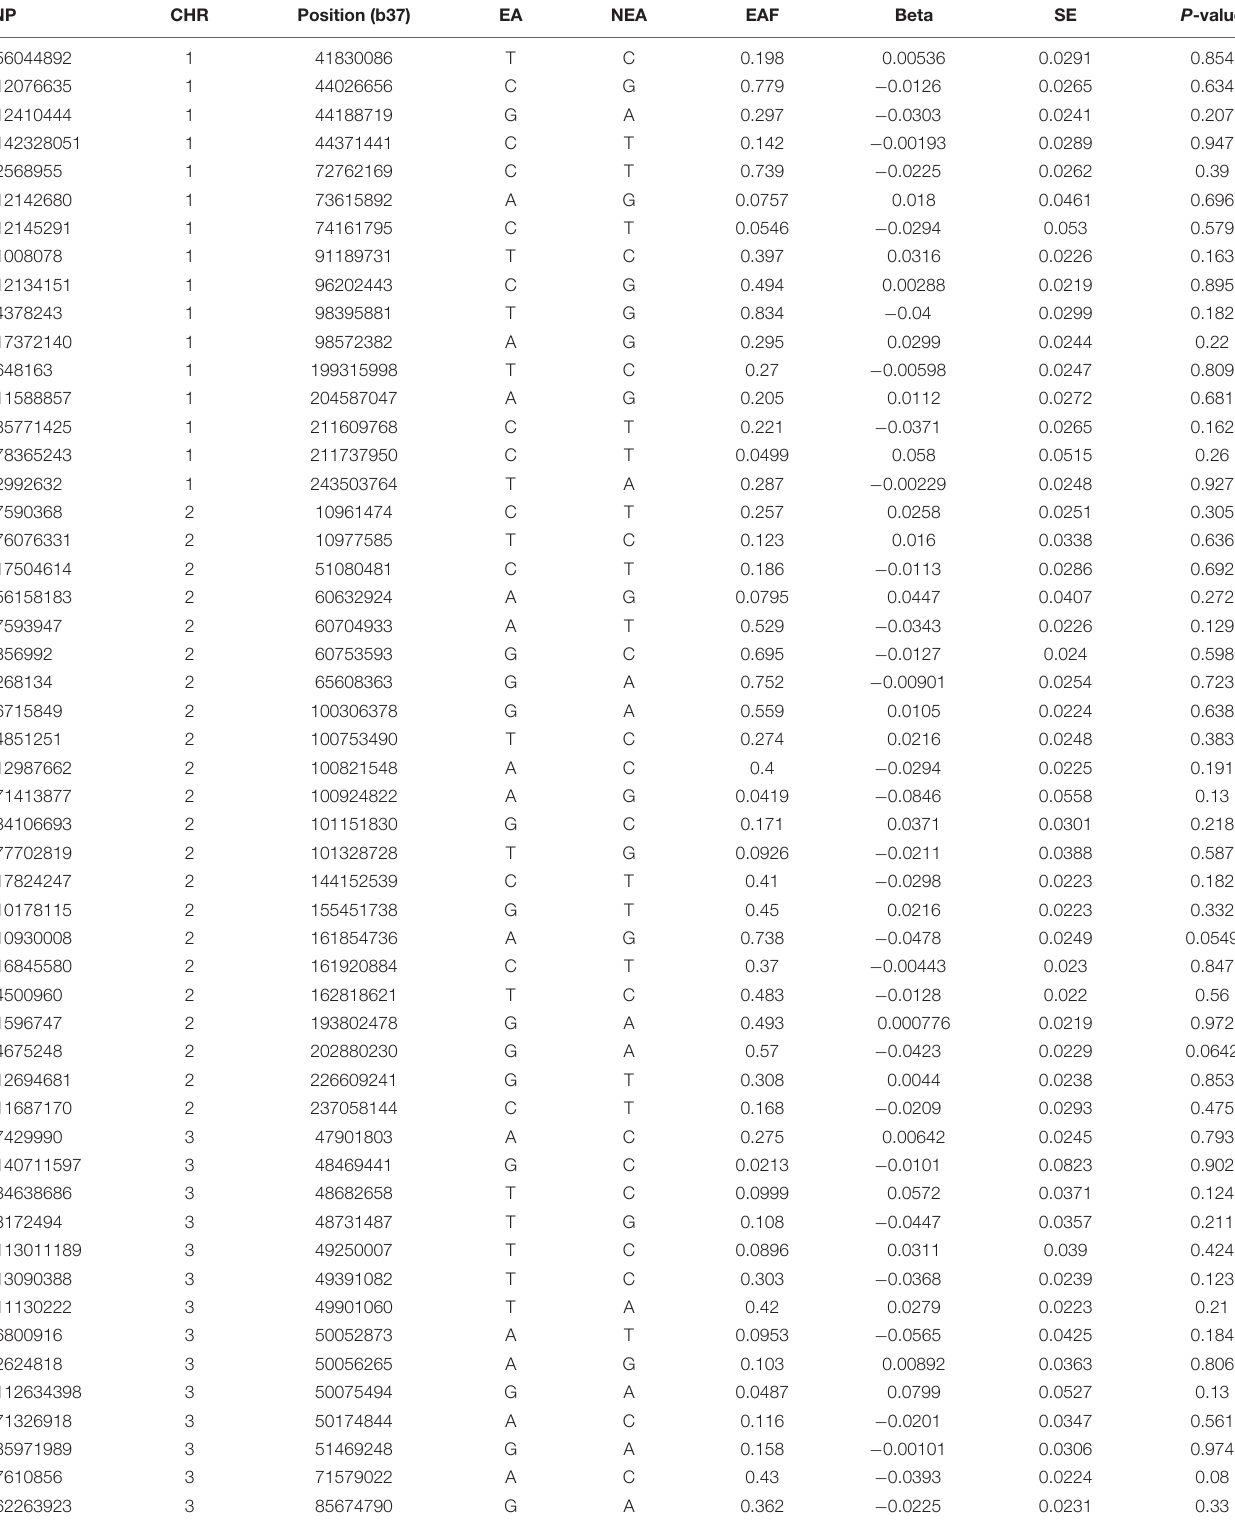
TABLE 3 | Association between 141 educational attainment genetic variants and